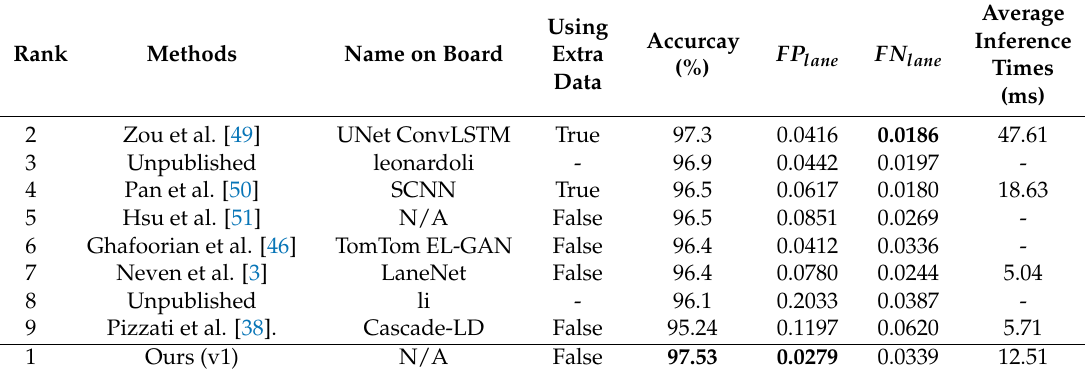
Table 2. TuSimple lane marking challenge leaderboard (test set) as of 14 March 2018 [46].